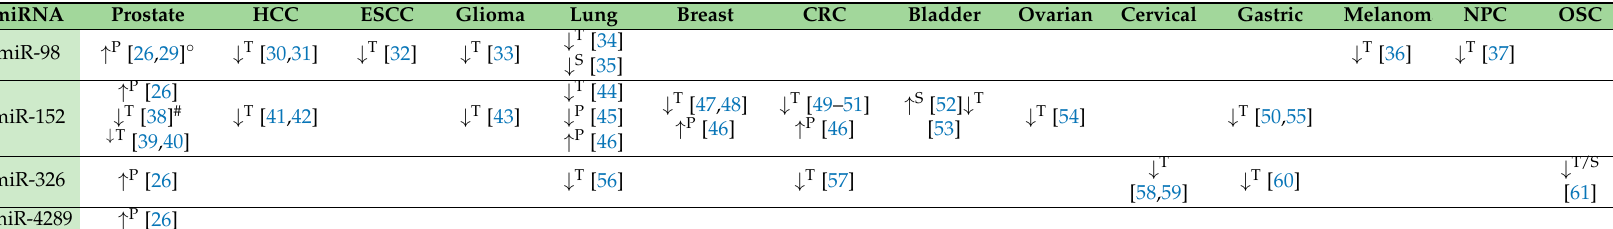
Table 1. Dysregulation of miR-98, miR-152, miR-326 and miR-4289 in prostate cancer (PCa) when compared to cancer-free samples (tissue, serum or plasma). miRNA Prostate miR-98 miR-152 miR-326